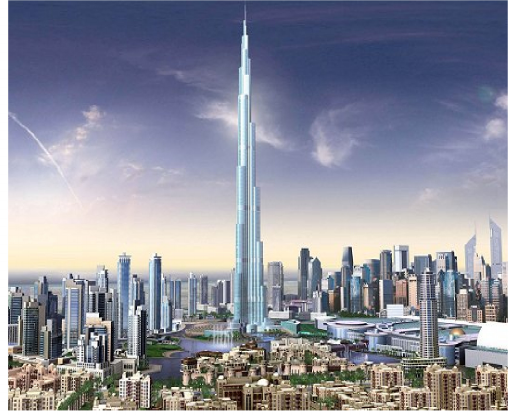
Figure 1. Borj Dubai (Dubai, 2008)